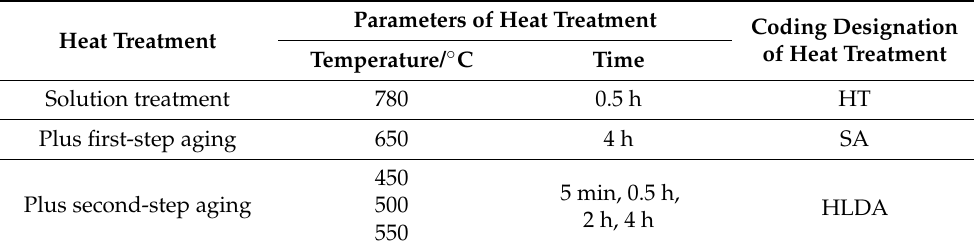
Table 2. Coding designation and the parameters of heat treatment. HT: solution treatment. SA: first-step aging. HLDA: second-step aging.